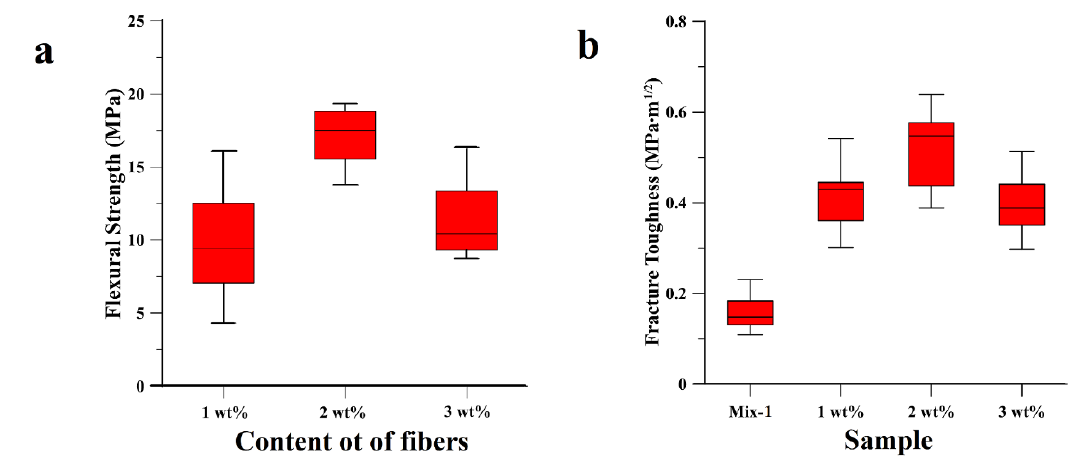
Figure 3. Comparative study of the mechanical and fracture performances of the cellulose fibers geopolymer matrix composites in terms of ( a ) Flexural strength of samples with 1 wt%, 2 wt% and 3 wt% of dispersed cellulose fibers and ( b ) fracture toughness of the geopolymer sample (Mix-1 formulation) and geopolymer matrix composite samples (1 wt%, 2 wt% and 3